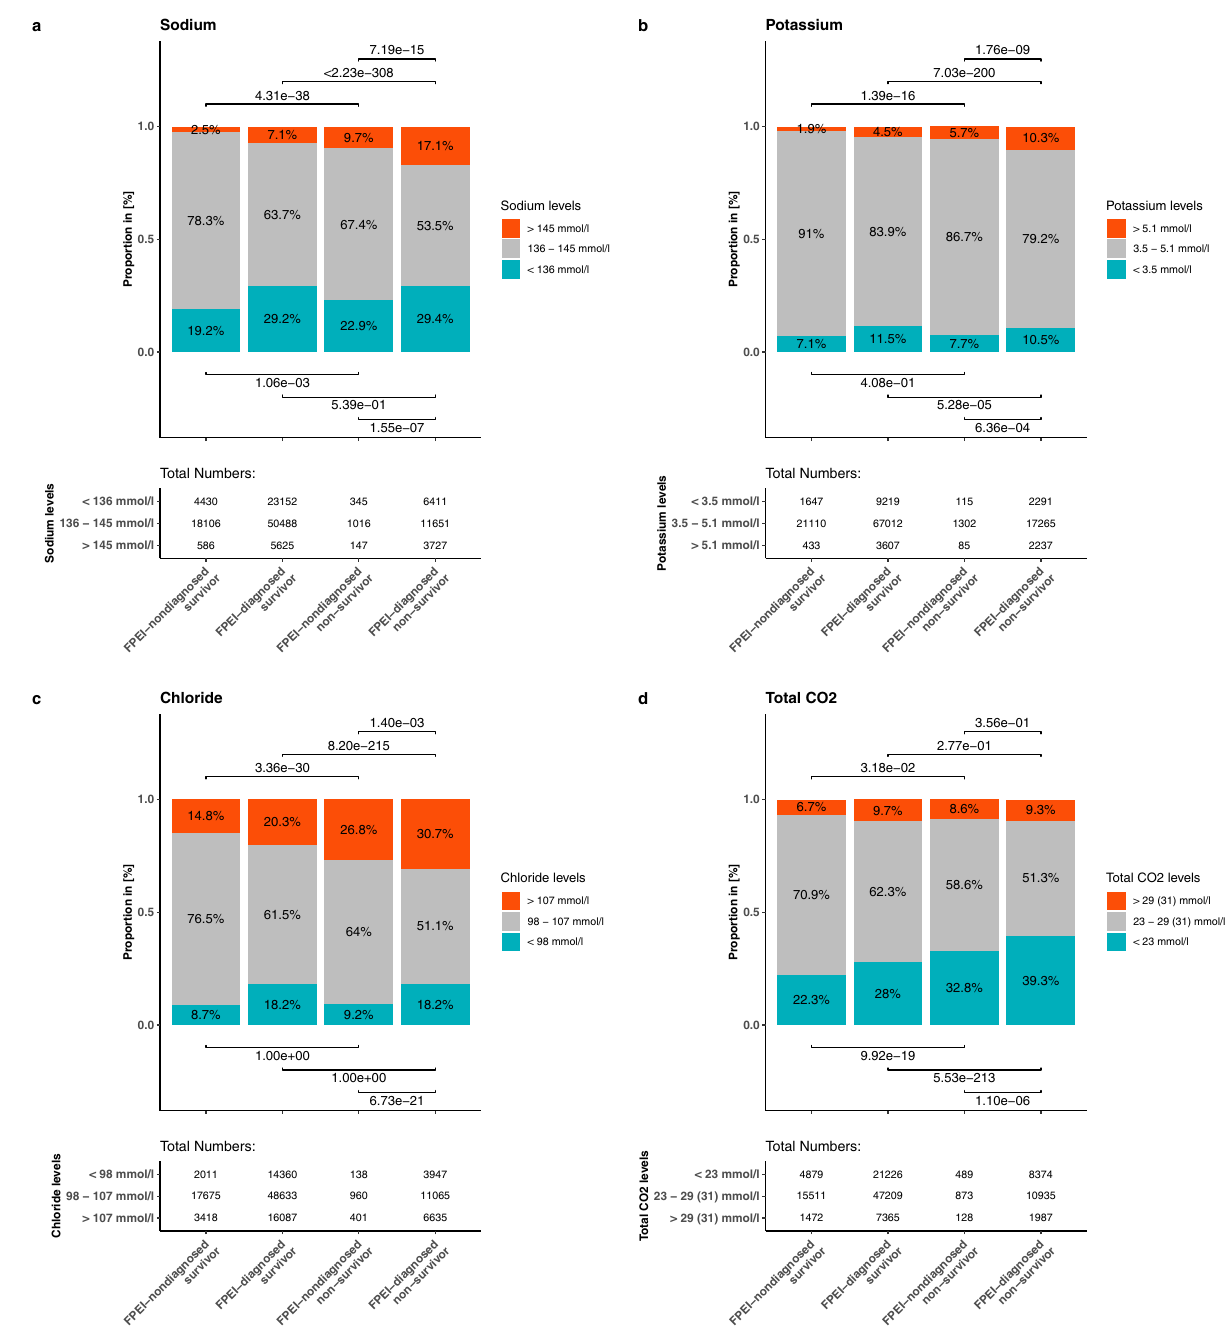
Fig. 3 Measurements with abnormally high/low levels of electrolytes during a COVID-19 infection. Proportions of daily median measurements per patient, with normal (gray), abnormally high (orange), or abnormally low (cyan) levels of a sodium, b potassium, c chloride, or d total CO 2 in the thirty days following the COVID-19 diagnosis date are shown. The four bars in each plot show measurements from survivors/non-survivors with/without a priori diagnoses with fl uid, pH, and electrolyte imbalance (FPEI). Fisher ’ s Exact test used for pairwise comparison of categories, Bonferroni correction applied. For the N = number of median daily measurements in each category, see the table inserts in the fi gure sodium or total CO2 (Fig. 3a – d, pairwise comparisons between fi rst and third bars). Within the FPEI-diagnosed cohort, non- survivors were more likely to have sodium, potassium or chloride levels above, or total CO2 levels below reference values (Fig. 3a – d,